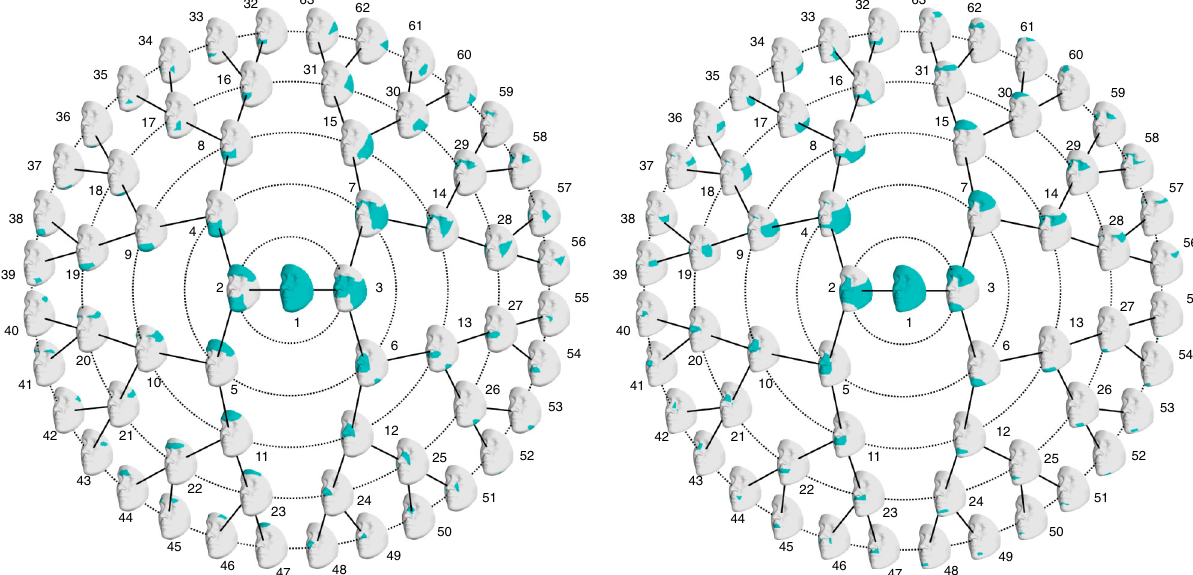
Fig. 3 Hierarchical facial segmentations. Facial segments are colored in blue. (left) For the GLOBAL cohort, globally, the area including nose, eyes, cheeks, and upper lip was fi rst separated from the rest of the face, and further partitioned into eyes and cheeks (quadrant 4, starting at segment 7), nose and lower-lateral facial area (quadrant 3, starting at segment 6). The remainder of the face was further partitioned into upper face (quadrant 2, starting from segment 5) and lower face (quadrant 1, starting at segment 4). (right) For the EURO cohort the nose, cheeks, lips were separated from the rest, and further decomposed into midface (quadrant 2, starting from segment 5), and cheeks and lower face (quadrant 1, starting from segment 4). The remainder of the face was composed of lower and upper face, which were further decomposed into upper face (quadrant 4, starting from segment 7), and lower face (quadrant 3, starting from segment